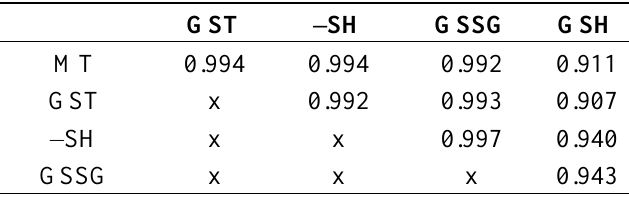
Table 3. Correlation coefficients between levels of MT, GST, GSSG and –SH moieties determined in S. aureus treated with cadmium(II) ions.